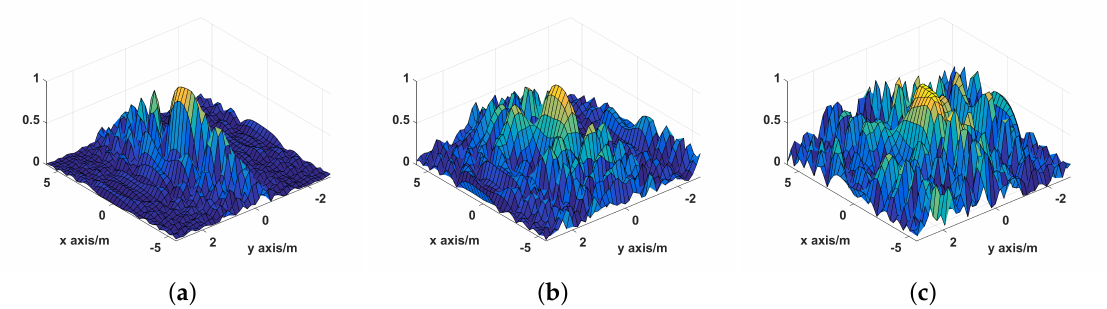
Figure 7. The point spread function of UPIM, DPIM, and SPIM. ( a ) UPIM; ( b ) DPIM; ( c )